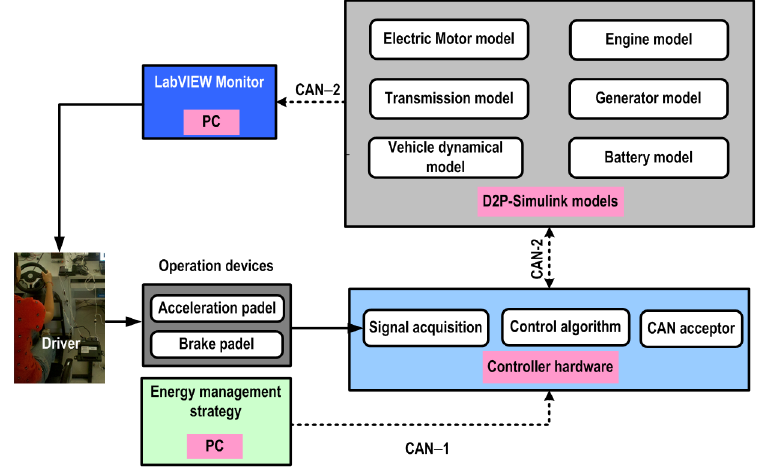
Figure 7. Schematic diagram of driver-in-the-loop experiment